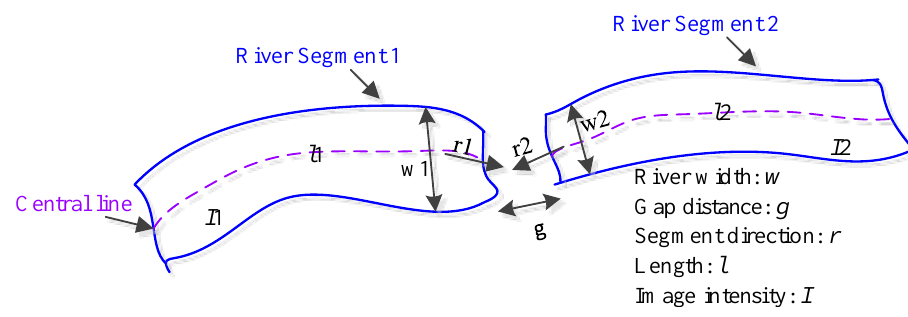
Figure 5. The conceptual model of river segment connection. The conditions that can infer the consecutiveness of two river segments include the gap width, the river direction consistency, the river width consistency, the minimum river length, and the image intensity